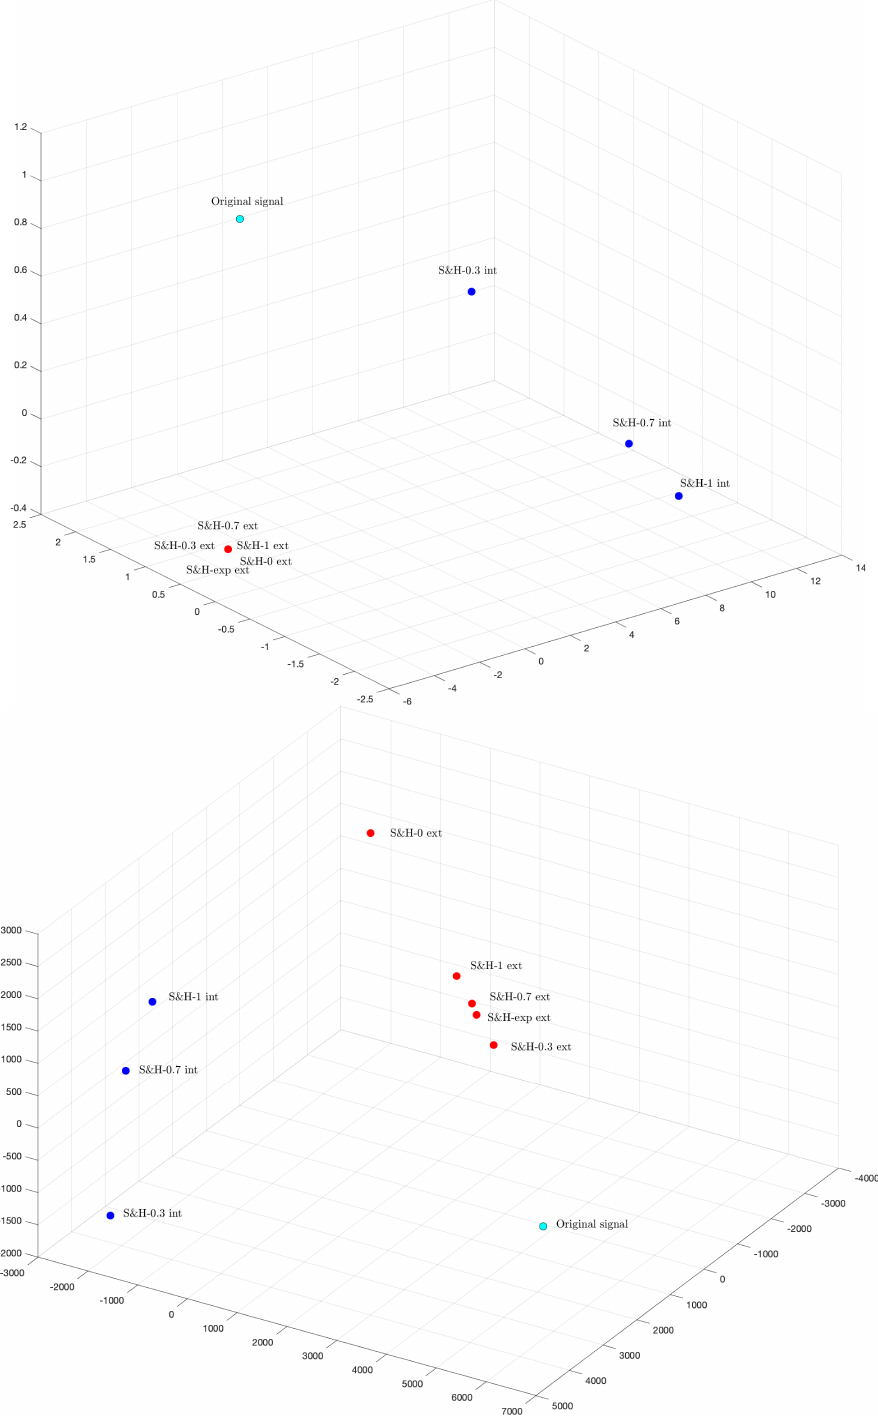
Figure 4. The MDS 3-dimensional plots using the Euclidean and Canberra distances, for the frequency response of the extrapolations of the S&H-0, S&H- α (with α = 0.3 and α = 0.7), S&H-1 and S&H-exp (with τ = 200) and interpolations with S&H- α (with α = 0.3 and α = 0.7) and the